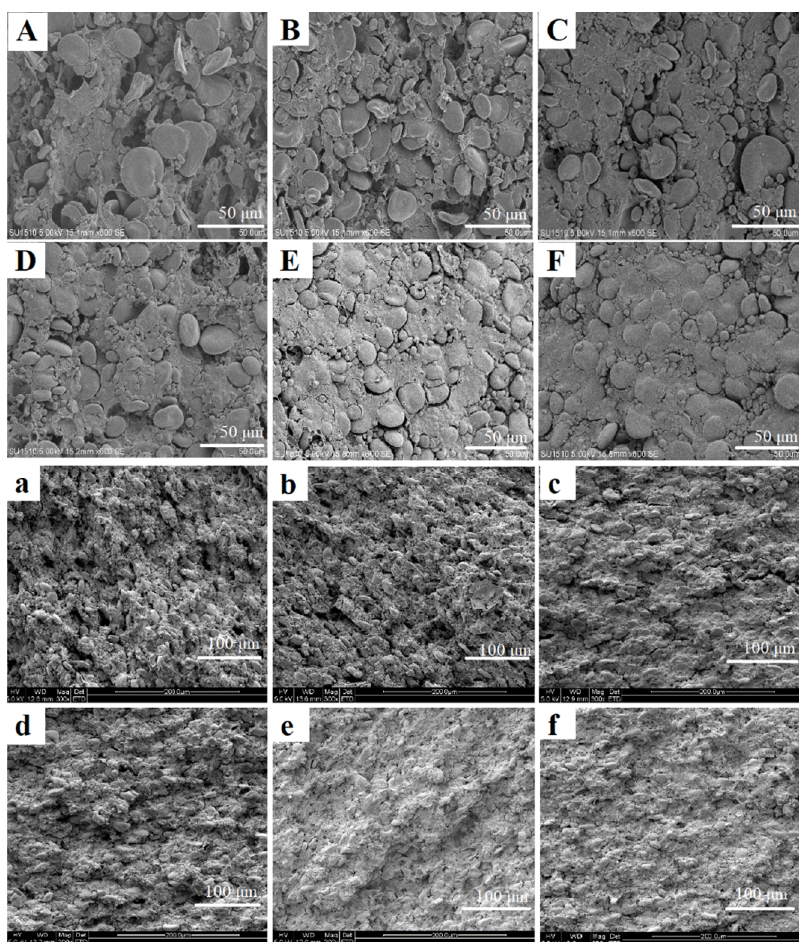
Figure 3. Microstructure changes of fresh noodles after humidity-controlled dehydration (HCD) treatment. ( A – F ), surface of HCD noodles with 40 °C-50%, 40 °C-90%, 60 °C-50%, 60 °C-90%, 80 °C-50%, 80 °C-90%; ( a – f ), cross sections of HCD noodles with 40 °C-50%, 40 °C-90%, 60 °C-50%, 60 °C-90%, 80 °C-50%, 80 °C-90%.